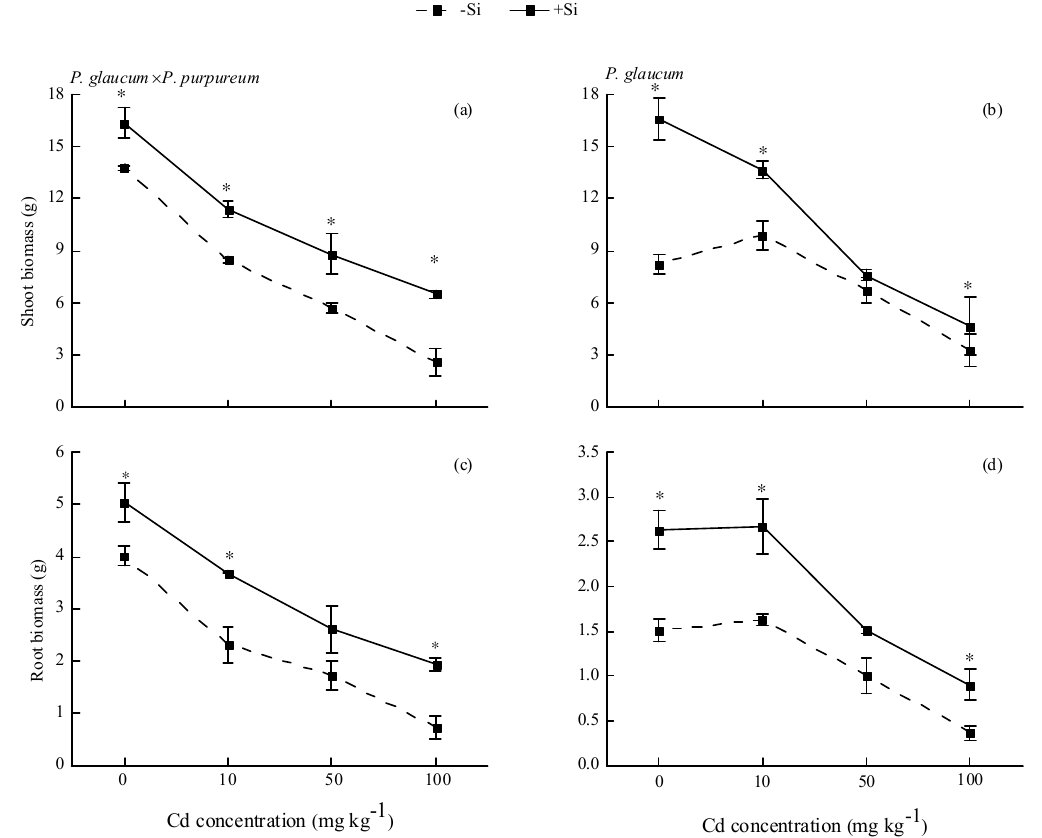
Figure 1. Effects of Si on the biomass of Pennisetum under Cd stress. ( a , c ) shoot and root biomass of P. glaucum × P. purpureum ; ( b , d ) shoot and root biomass of P. glaucum. Values are mean ± SE ( n = 3). * indicates significant difference between different treatments of the same variety, according to one-way ANOVA followed by the Duncan test ( p < 0.05).